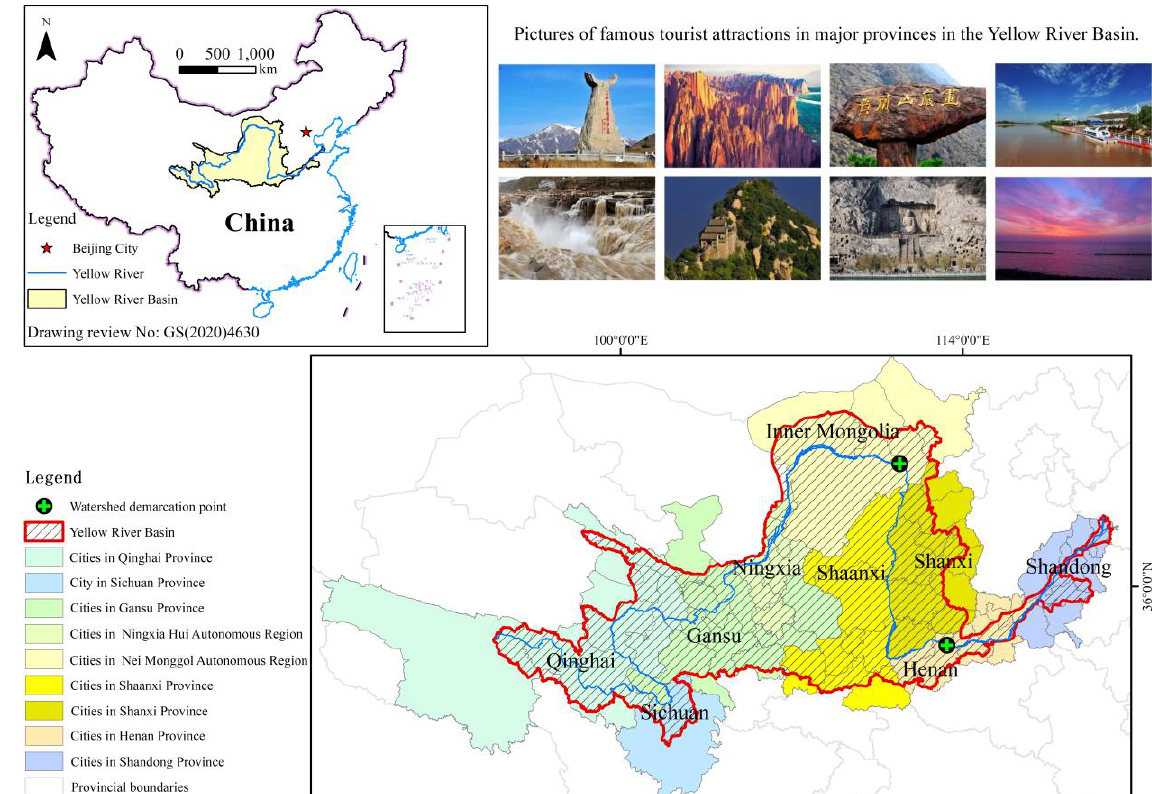
Figure 1. Overview of the research region in the Yellow River basin.